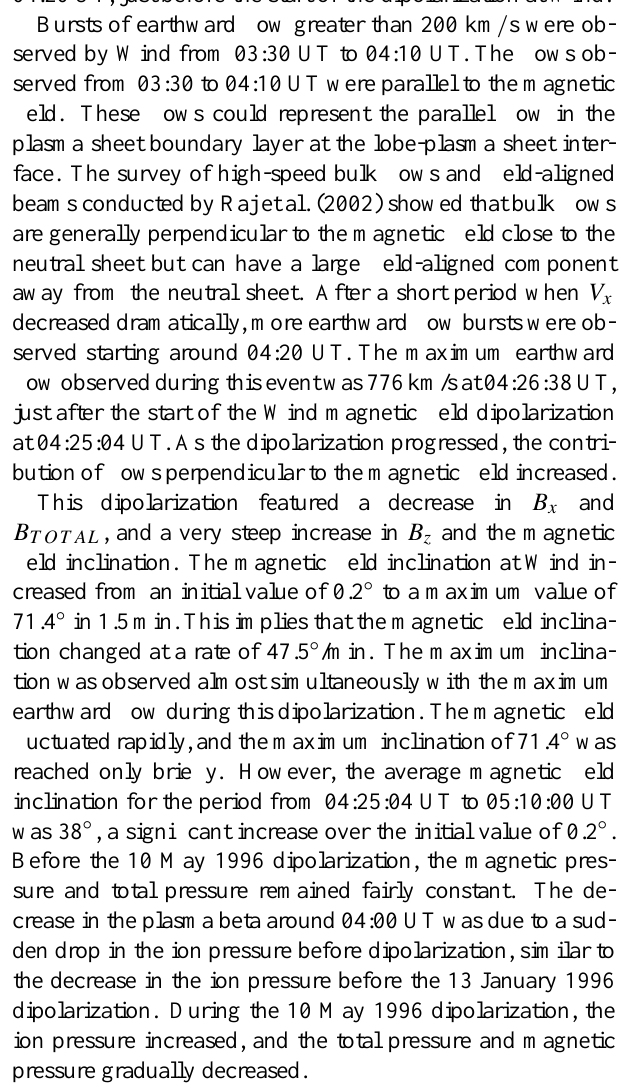
Fig. 4. Wind, CANOPUS and GOES 8 data from 03:30 to 05:30 UT on 10 May 1996. Figure 4 is the same format as Fig. 2. GOES 8 was located between 22.3 LT to 0.2 LT for the time period shown in the